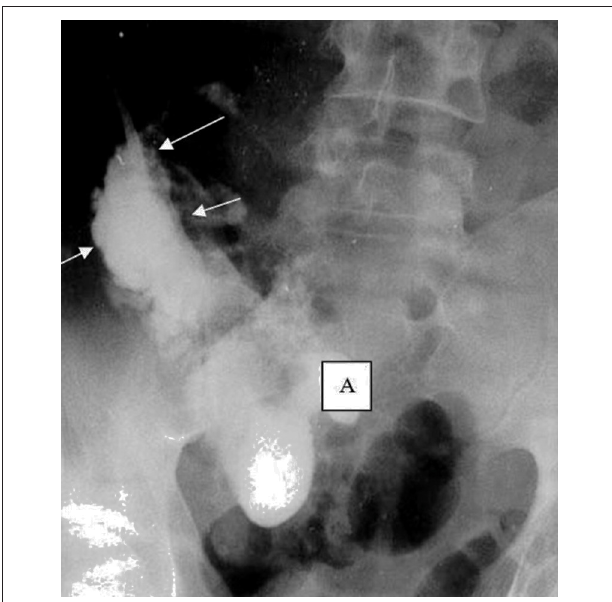
FIGURE 1 | Ultrasound image of the abdominal abscess (arrows) and a sequestrum